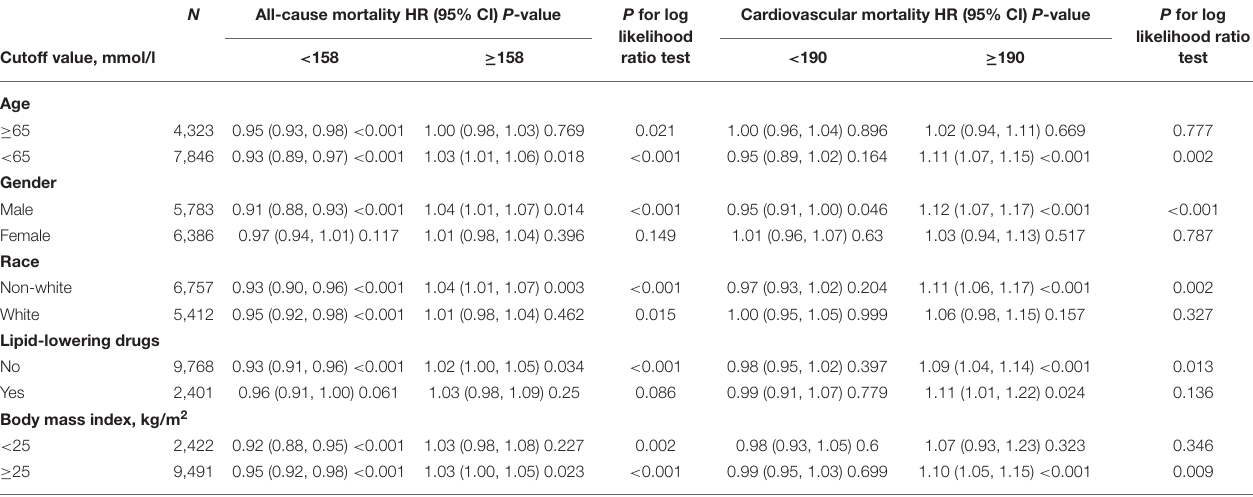
TABLE 4 | Subgroup analysis. N All-cause mortality HR (95% CI) P -value P for log